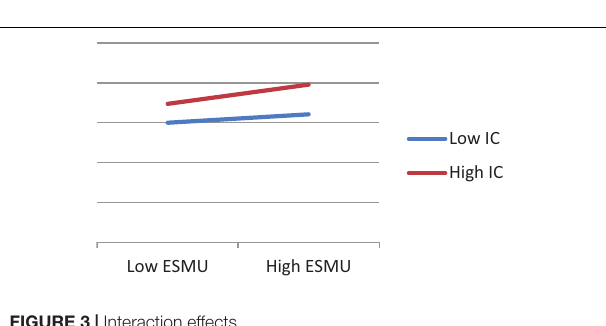
FIGURE 2 | SEM analysis of the research model. ∗ p < 0.05; ∗∗∗ p < 0.001.